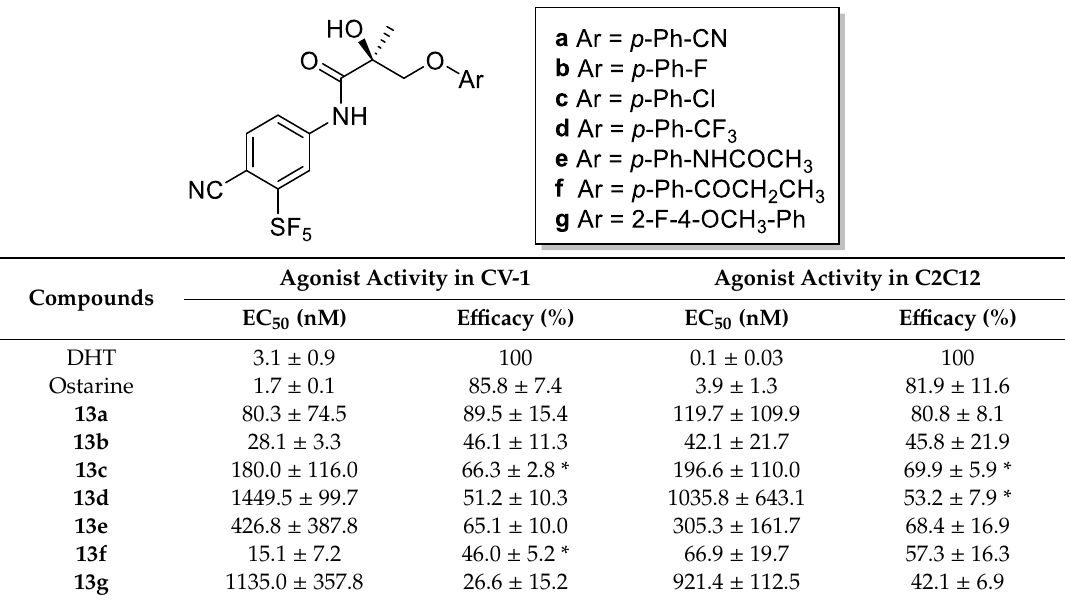
Table 1. AR (androgen receptor) agonist activity of ostarine derivatives.